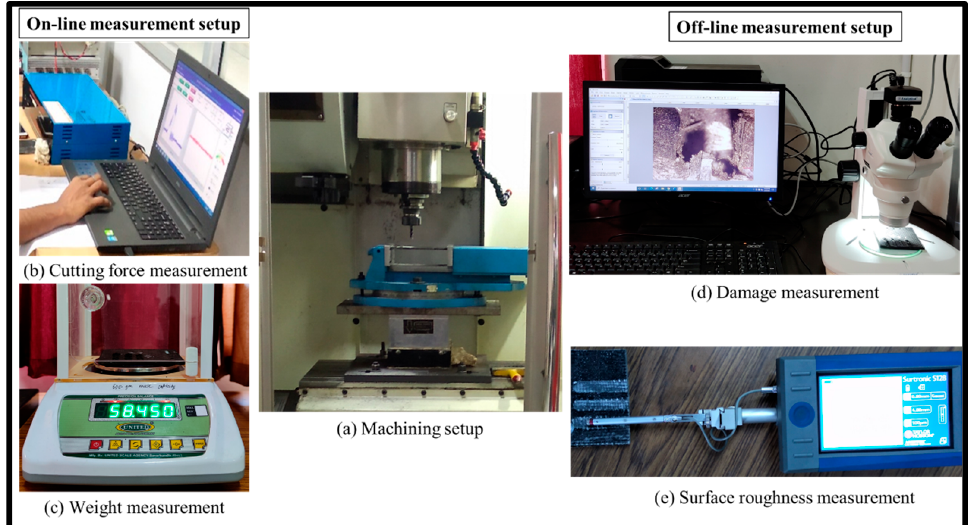
Figure 2. Experimentation setup. ( a ) Machining setup, ( b ) cutting force measurement, ( c ) weight measurement, ( d ) damage measurement and ( e ) surface roughness measurement. Table 2. Process parameters and their working range.